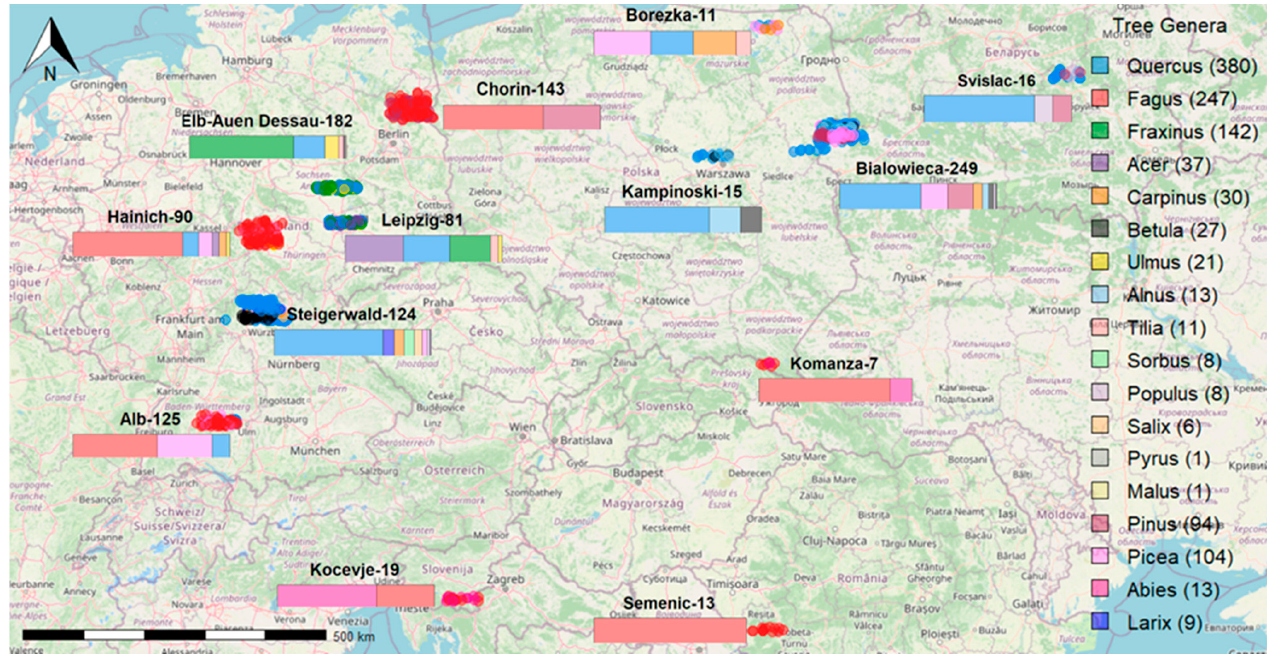
Figure 1. The map of study sites in Central Europe shows an almost representative coverage. Trees fogged were plotted and visualised as differently coloured dots, which were jittered for better visualisation. The coloured bar graphs show the percentage of tree genera fogged per site, together with the total number of foggings in brackets. All sites with seven trees, or more, are shown.